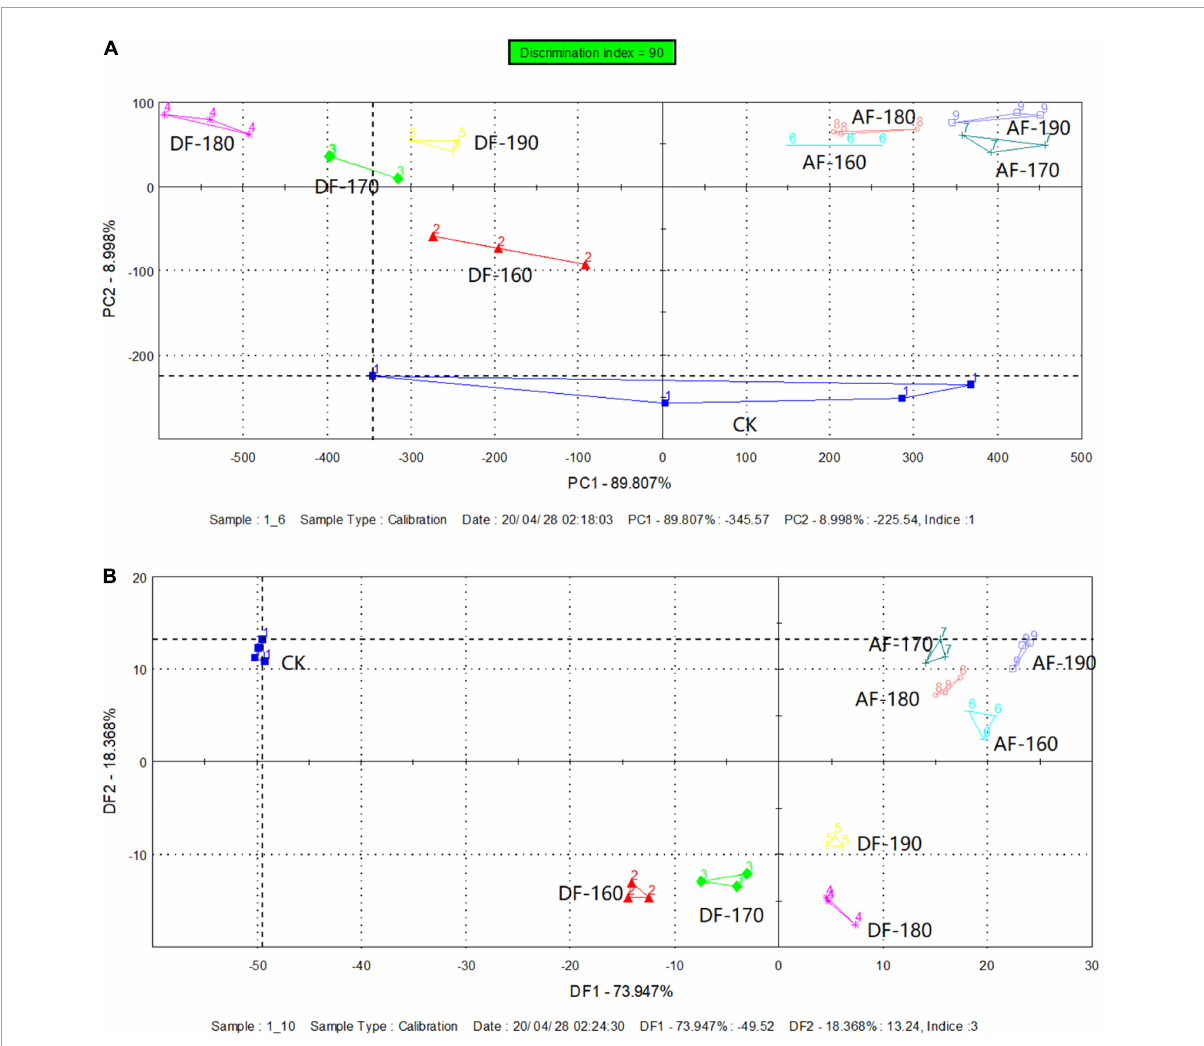
FIGURE2 Effect of frying method and temperature on principal component analysis (PCA) (A) and discriminant factor analysis (DFA) (B) of shrimp meat taste. DF, shrimp meat was treated with deep frying; AF, shrimp meat was treated with air frying; 160, 170, 180, 190: The fried temperature of shrimp meat is expressed as 160, 170, 180, and 190 ◦